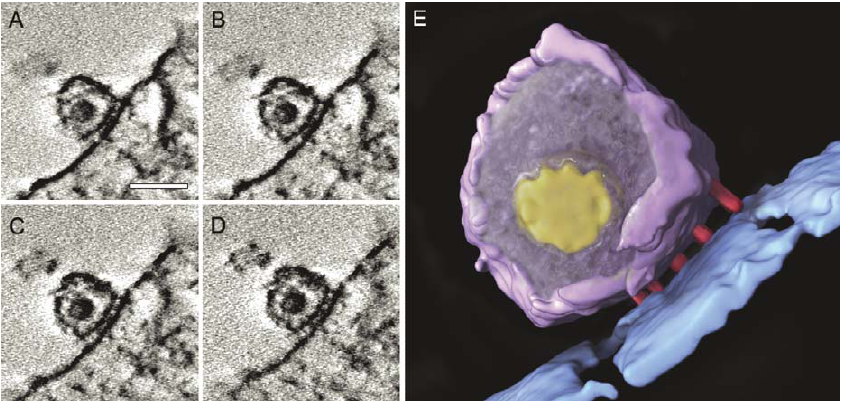
Figure 7. Imaging of HIV-1 in Contact with T Cells (A–D) Four slices at different depths in a tomogram of the contact between HIV-1 and T cells, with cells fixed following incubation for 1 h at 37 8 C. Scale bar is 100 nm long. (E) 3-D surface rendering of the tomographically derived architecture of the contact region between HIV-1 and the T cell membrane shown in panels (A–D), with color scheme as in panel (E) of Figure